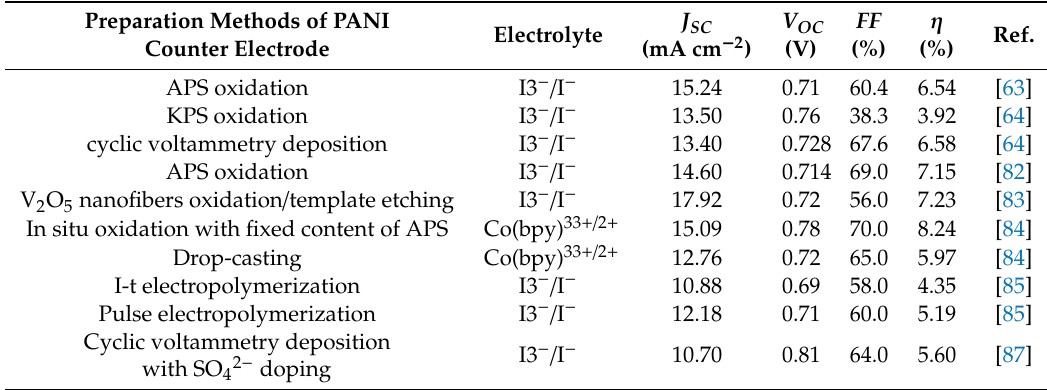
Table 2. Photovoltaic performance parameters of DSSCs based on the PANI counter